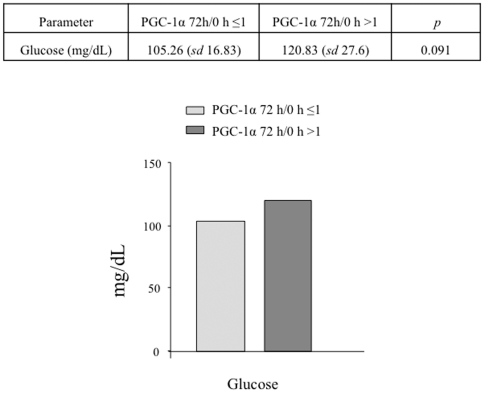
PGC-1α induction correlates with higher plasma glucose levels in the cohort of STEMI patients under survey.The estimated mean for patients that induced PGC-1α levels (PGC-1α 72 h/0 h ≥1) is compared to that of patients that did not induce PGC-1α (PGC-1α 72 h/0 h ≤1) after STEMI. Data are means +/−SD. (*) p<0.05.